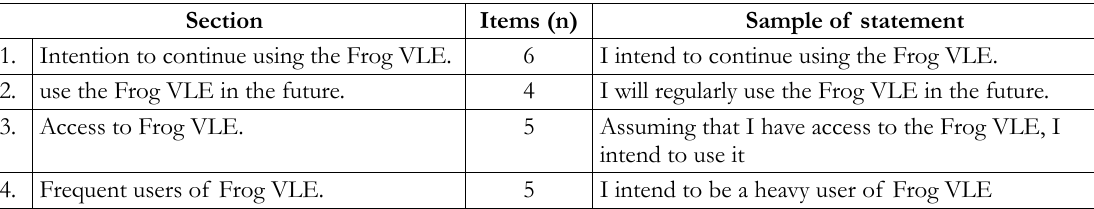
Table 1. The frequency and statement representative of the